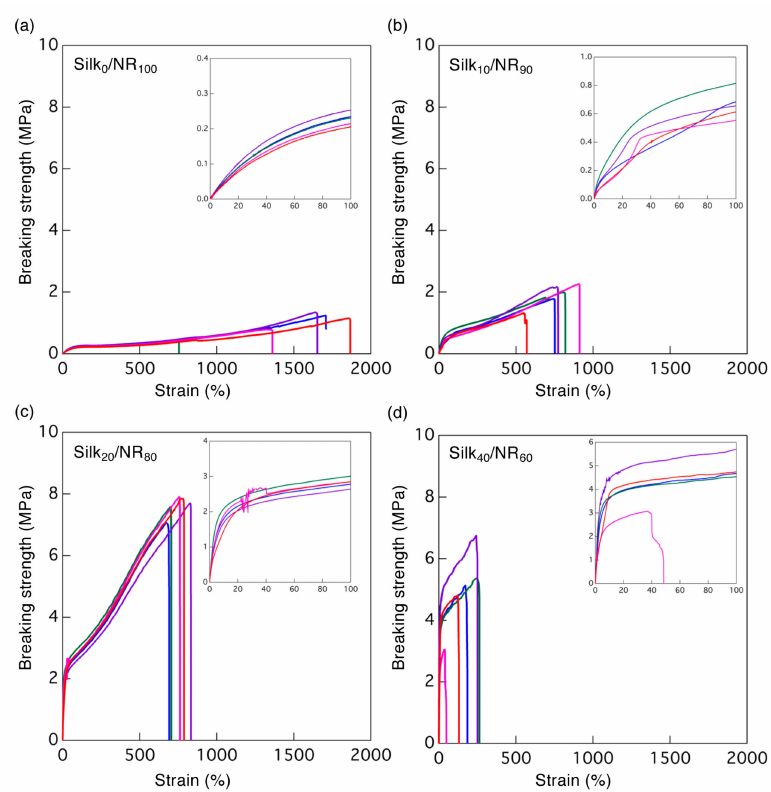
Figure 2. Stress-strain curves of ( a ) silk 0 / NR 100 (pure NR), ( b ) silk 10 / NR 90 , ( c ) silk 20 / NR 80 , and ( d ) silk 40 / NR 60 . Elongation rate: 10 mm / min. The inset focuses on the strain range between 0% and 100%.